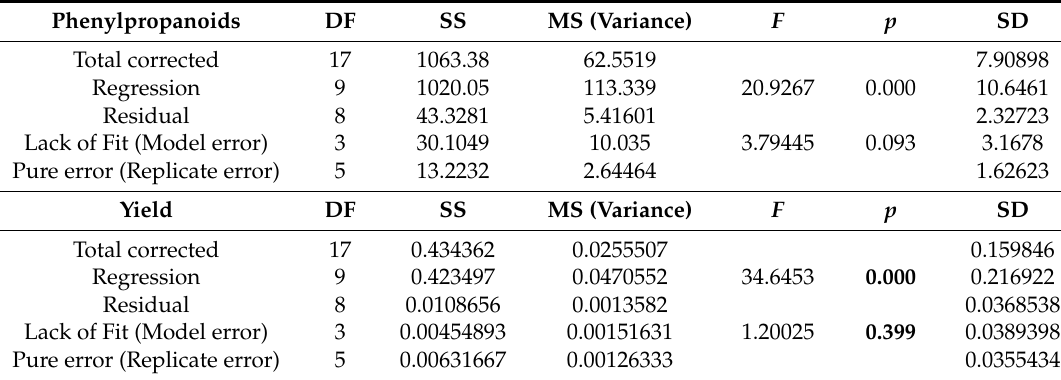
Figure 3. Plot of observed values versus predicted values for both responses. Table 2. ANOVA test for the model.